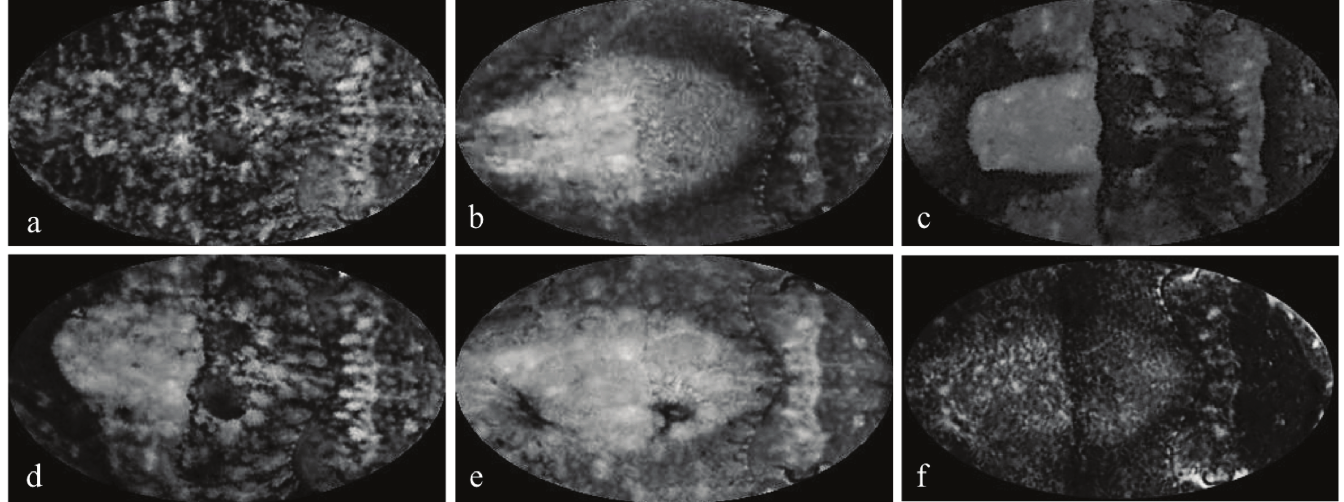
Fig 3. Example images used for camouflage categorization of segmented cuttlefish images. (a) 100% mottled, (b) 100% uniform, (c) 100% disruptive, (d) 50% mottled and 50% disruptive, (e) 50% mottled and 50% uniform, (f) 50% uniform and 50%